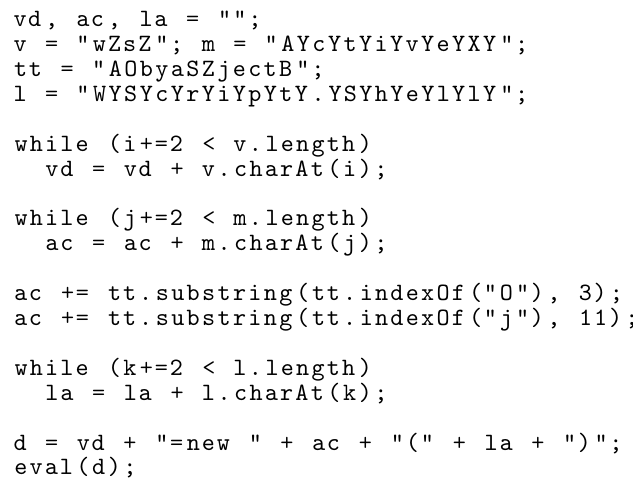
Figure 1. A potentially malicious obfuscated JavaScript